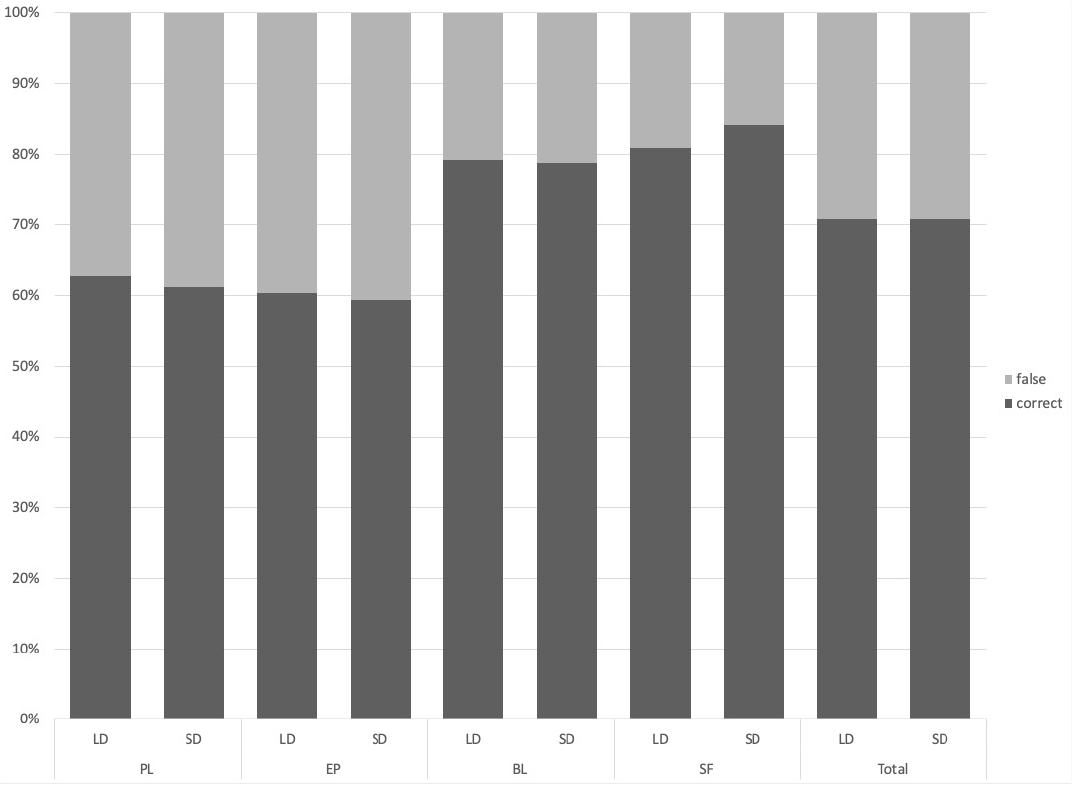
Figure 2. Detectability rates of the four different lesions (percentage).